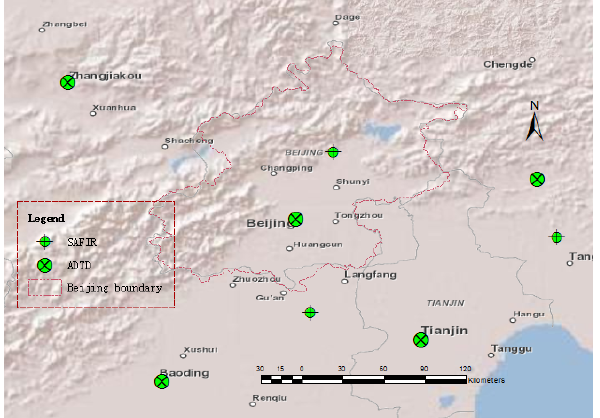
Figure 1. Distribution of SAFIR and ADTD detection stations around